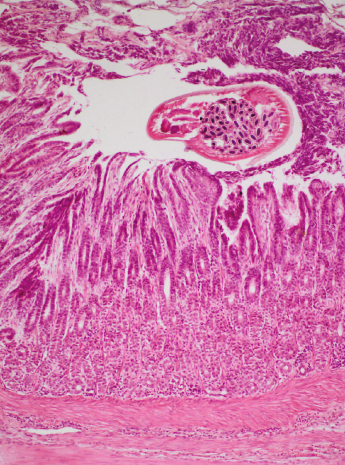
Figure 1: Photograph of stomach of rabbit showing a gravid female of A. strongylina cut transversely towards the lumen. Note denuda- tion of superficial lining of epithelium (H. E. original magnification × 100X).